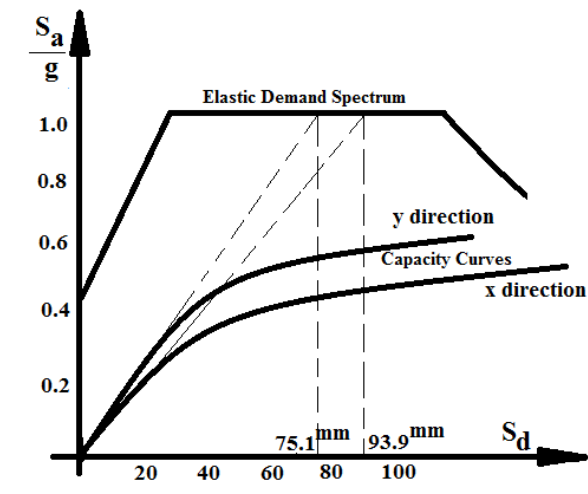
Fig. 14. Case study 1 (3-D structural model).